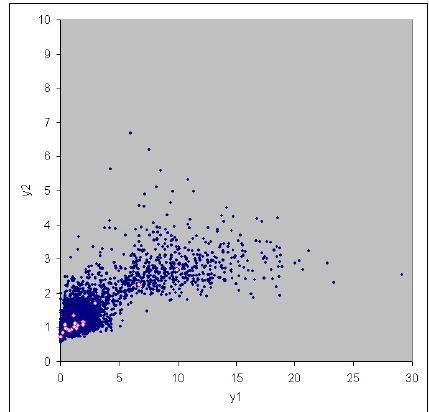
Figure 12. Simulation scatterplot, kernel density estimate. Small scale.